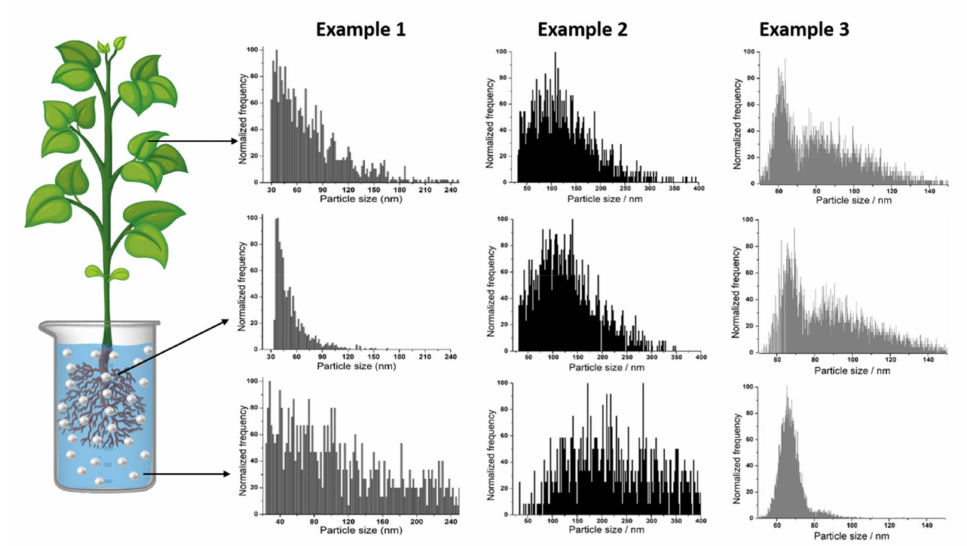
Figure 3. Comparison of size distributions obtained for metal-containing NPs in growth medium, roots and leaves in 3 di ff erent